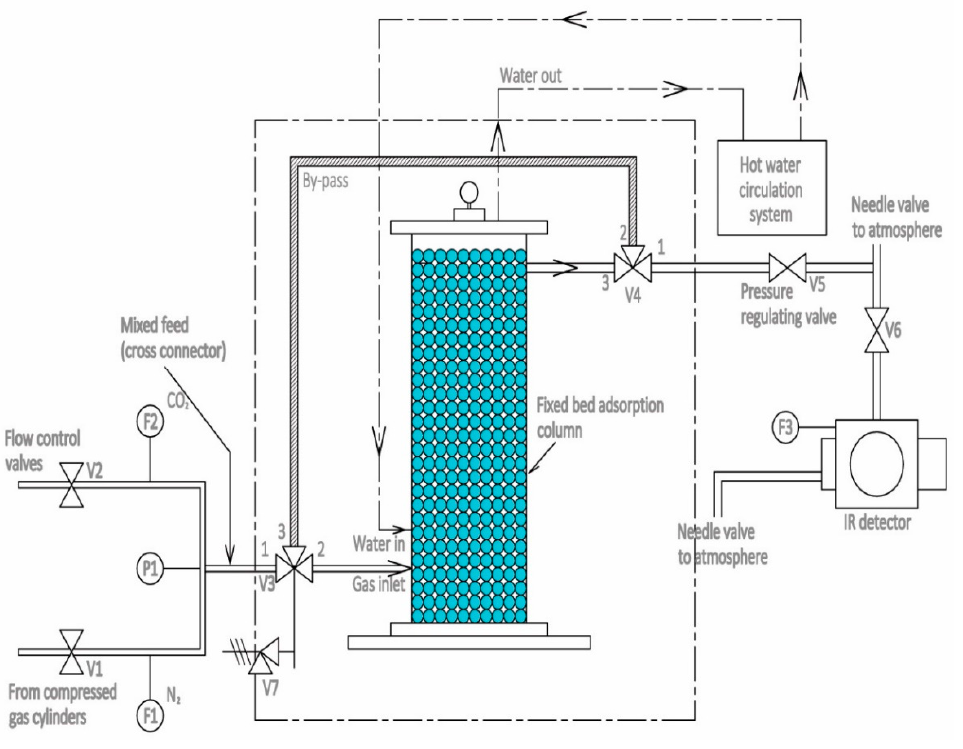
Figure 1. Fixed bed column [11]. Table 1. Sensitivity of the sensors used for